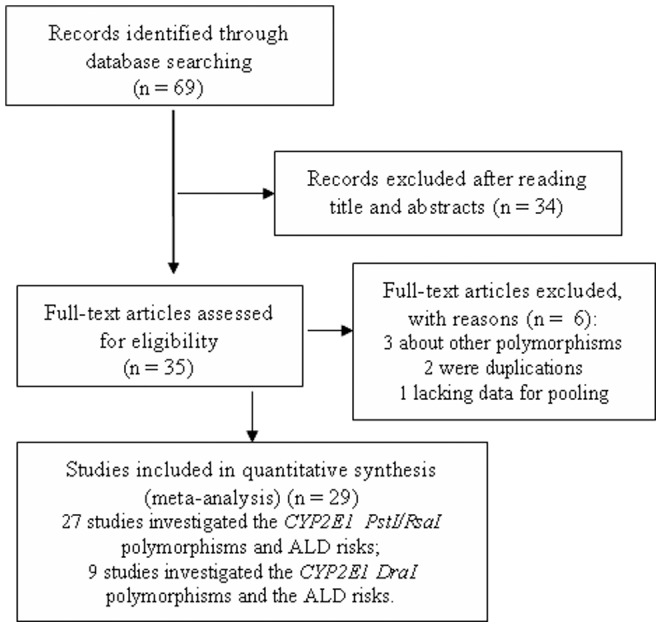
Flow chart of study selection based on the inclusion and exclusion criteria.